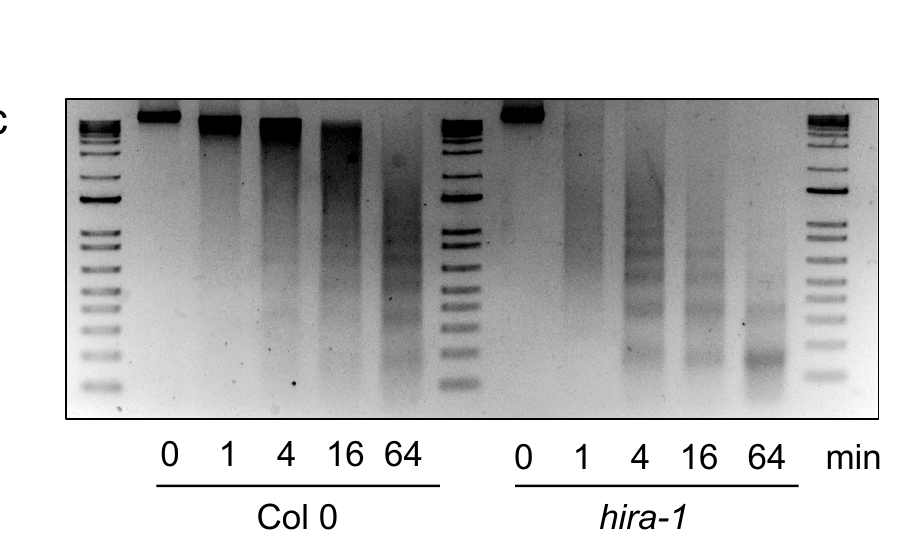
Figure 2. Loss of HIRA leads to reduced H3 content and MNase hypersensitivity. ( a ) Representative Western blot of H3 histones in total protein extracts from WT and hira-1 mutant dry seeds. ( b ) Quantification of H3 band intensities relative to ACTIN from three biological and four technical replicates. One wild type sample was set to 1 in each technical replicate. Statistically significant differences relative to WT were determined using a two-sided Student’s t -test (* p < 0.05). ( c ) Nuclei from WT or hira-1 mutant seeds were isolated and incubated with MNase for 1, 4, 16 and 64 min. Equal amounts of digested DNA were loaded on an agarose gel and stained with ethidium bromide. One experiment of three biological replicates with similar results is